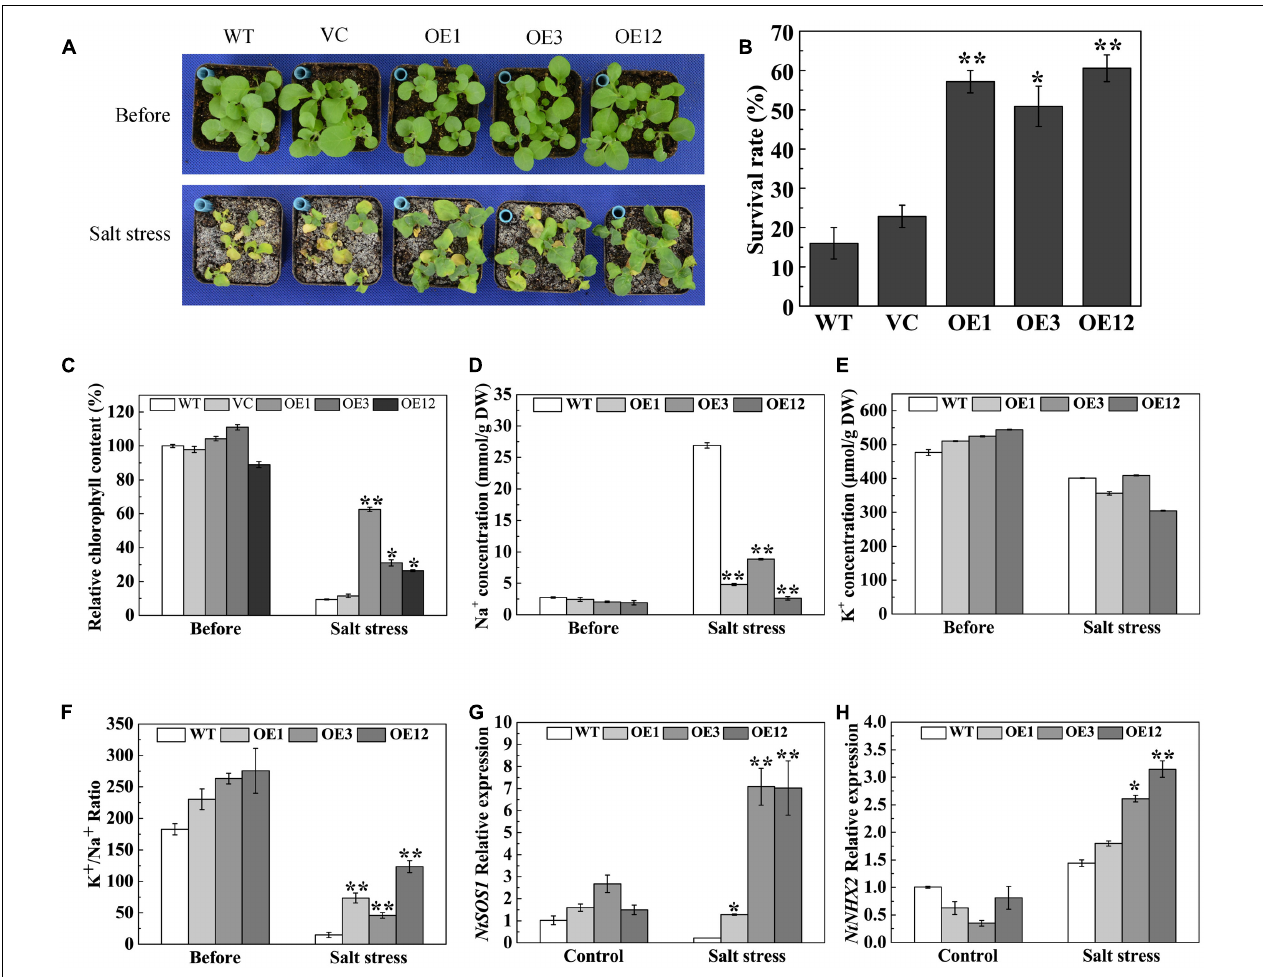
FIGURE 6 | Salt tolerance of TaODORANT1 overexpressed tobacco plants. (A) Phenotype of WT, VC and OE lines (OE1, OE3, and OE12) after salt treatment. (B) Survival rate statistical analysis. (C) Chlorophyll content in leaves. (D,E) Na + and K + concentrations in leaves. (F) K + /Na + ratio. (G,H) Expression levels of ion transporter genes. Three independent biological replicates were performed and produced similar results. Vertical bars refer to ± SE ( n = 3). Asterisks indicate significant difference between the WT and the transgenic lines ( ∗ P < 0.05; ∗∗ P <